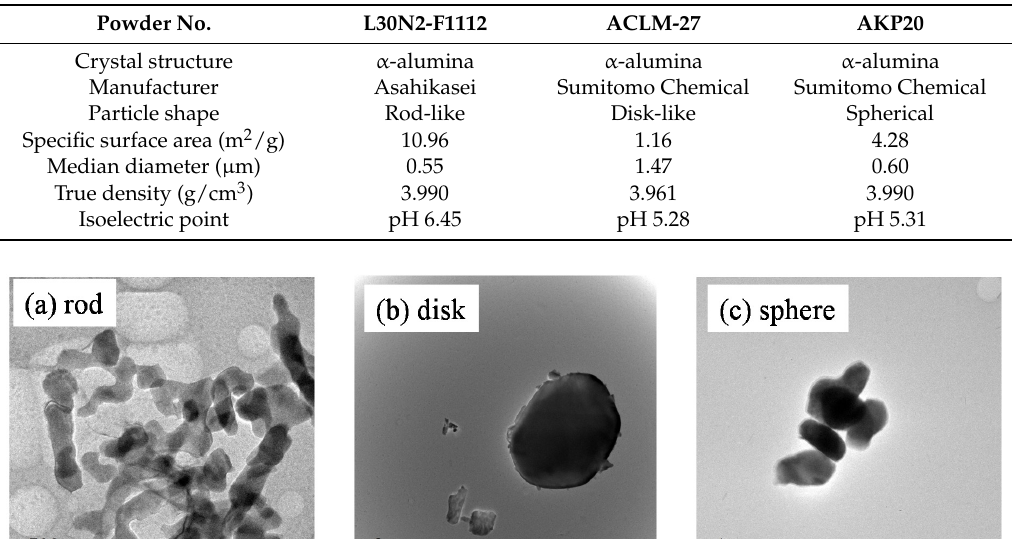
Table 1. Properties of starting alumina particles.